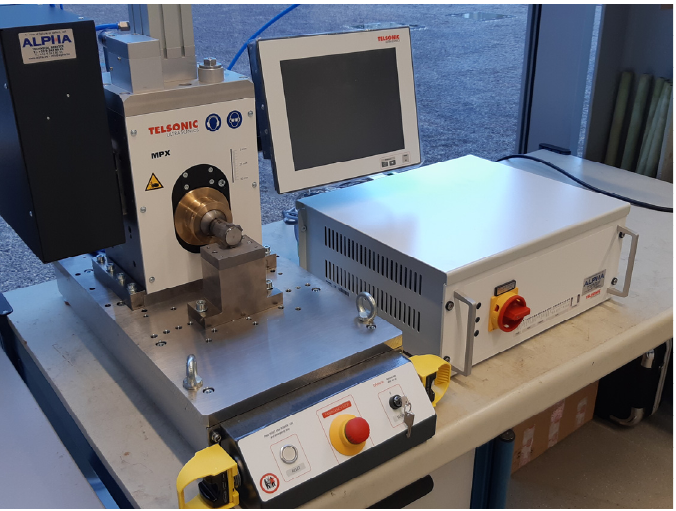
Figure 2. Telsonic MPX ultrasonic welding